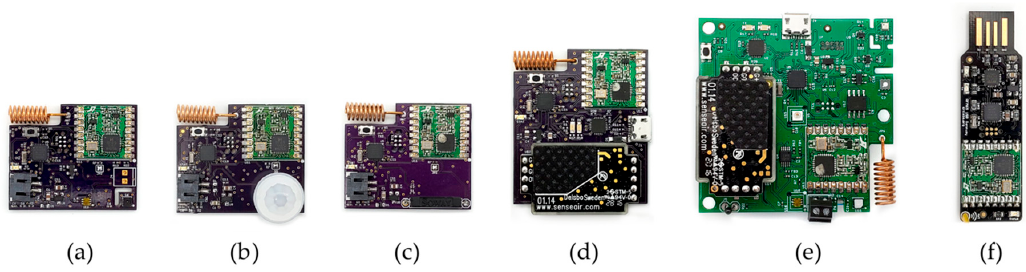
Figure 2. Low-power wireless sensor nodes measuring ( a ) temperature, relative humidity, and light / room occupancy, ( c ) door / window opening, and ( d ) CO intensity, ( b ) motion/room occupancy, ( c ) door/window opening, and ( d ) CO 2 concentration; ( e ) an intensity, ( b ) motion